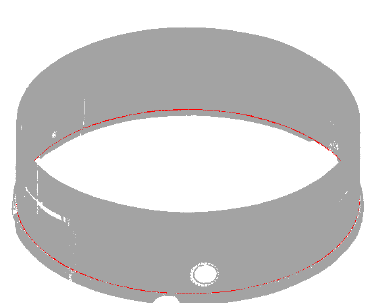
Fig. 6 The extraction result of datum feature